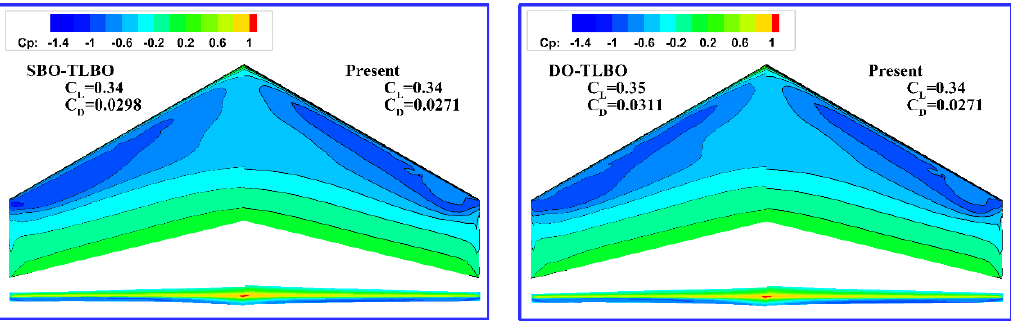
Figure 11. Comparisons of C p and shape with the different sectional airfoils.